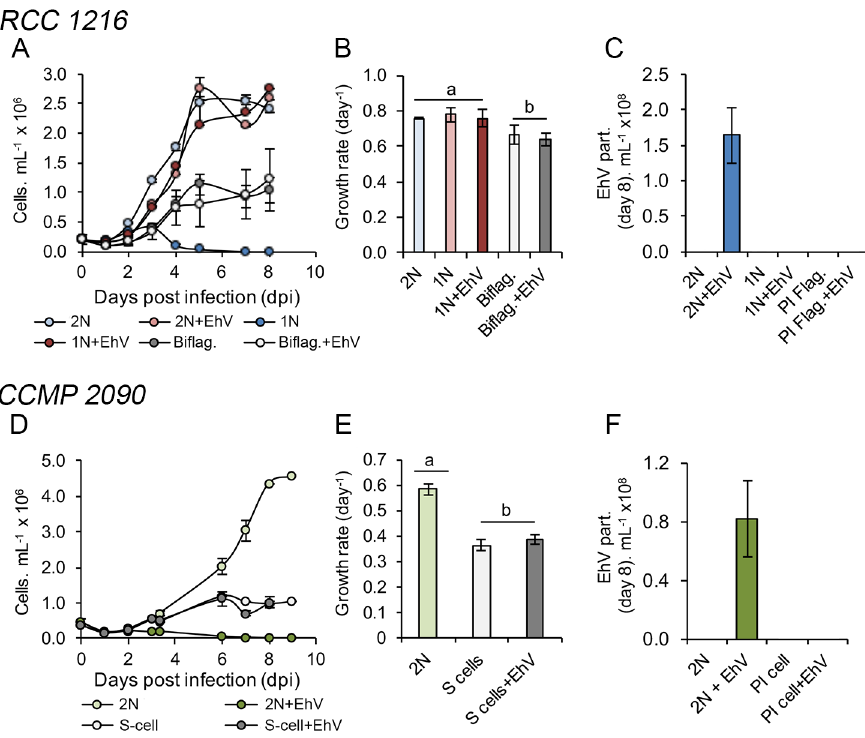
Fig 4. Growth dynamics and susceptibility to infection of biflagellate and nonmotile-S cells isolated after EhV infection. (A) Growth dynamics of a representative biflagellateclone (PI Flag.) relative to RCC 1216 (2N) and RCC 1217(1N) in controls and during viral infection by EhV-201. (B) Growth rate and (C) EhV production as determined by flow cytometry. (D) Growth dynamics of representative nonmotile-S cells (PI Flag.) relativeto CCMP 2090(2N) in controls and in the presence of EhV-201. (E) Growth rate and (F) EhV virion production as determined by flow cytometry. The symbols a and b shown in (B) and (E) distinguish treatments groupsthat are identicalfrom those that are different, respectively, followingstatistical analyses( t - test). E . huxleyi RCC 1216, 2N calcifiedstrain was the parentalstrain for clonal isolationin (A–C), and E . huxleyi CCMP 2090, 2N calcifiedstrain in (D–F). The mean ± standarddeviationof triplicate cultures is